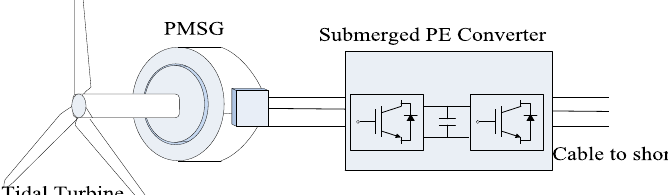
Figure 1. Tidal turbine drive train with a direct-drive permanent magnet synchronous generator (PMSG) and a power electronic (PE) converter [2].